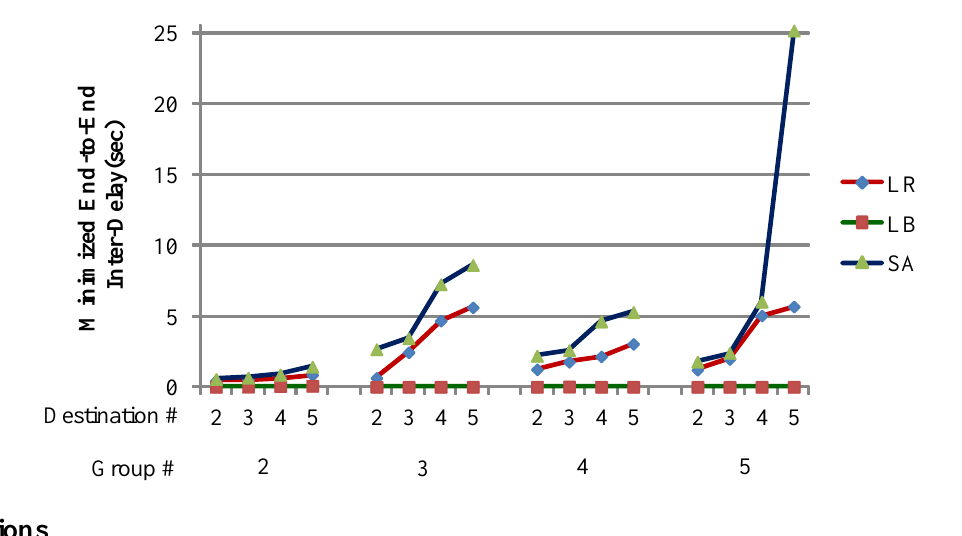
Figure 11. Inter-group end-to-end